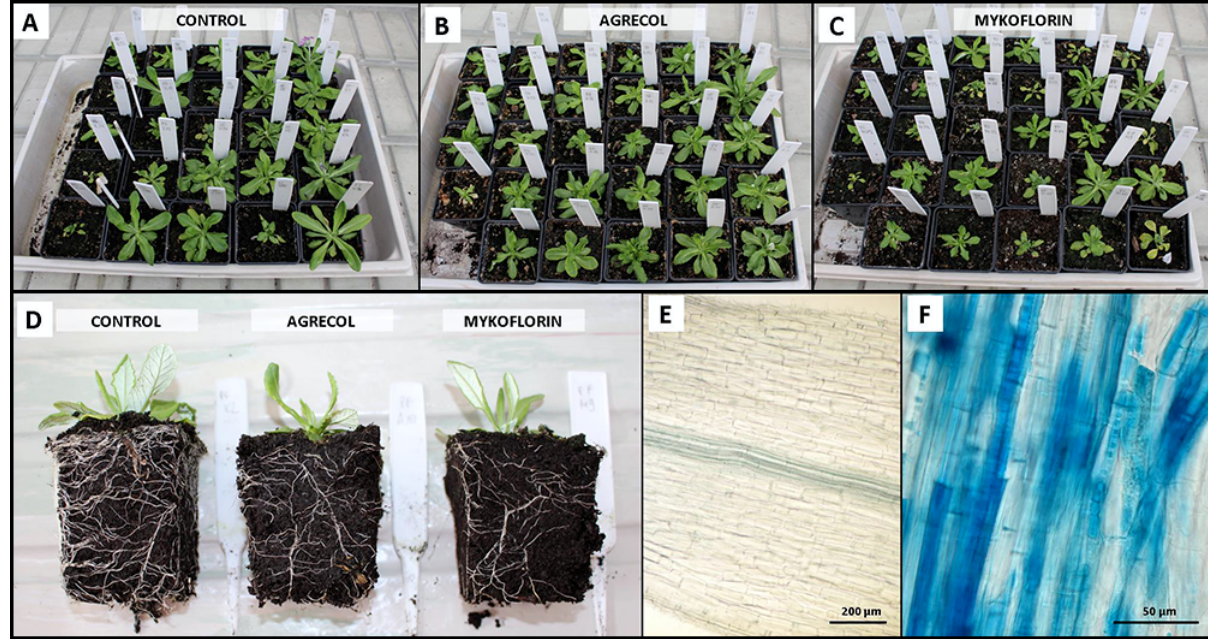
Figure 3 Primula farinosa plants after cultivation in controlled condition and mycorrhization. ( A–C ) The morphology of plants. ( D ) Root systems. ( E,F ) Microscopic observation of roots after mycorrhization with Mykoflorin: not colonized ( E ); with fungi of nonmycorrhizal character ( F ). Roots were stained with aniline blue.